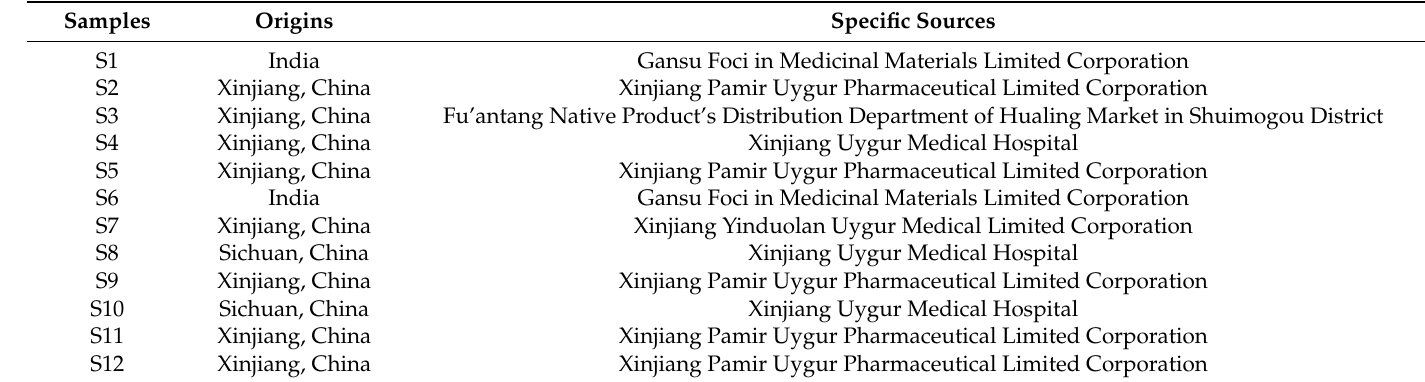
Table 1. Twelve batches of the fruit of C. fistula .